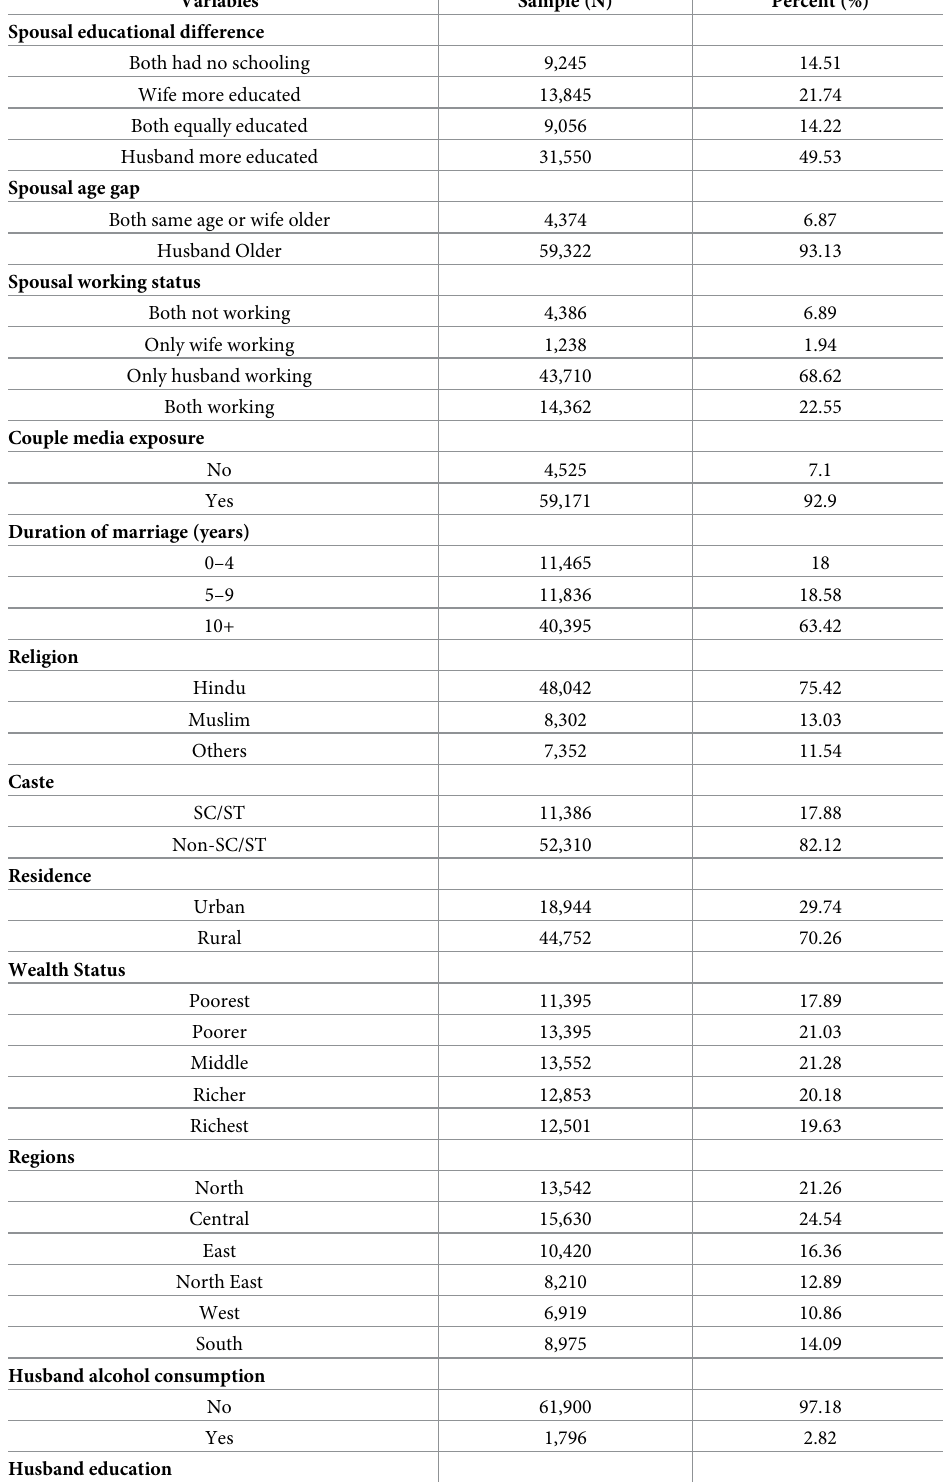
Table 1. Socio-demographic profile of the study participants (N =